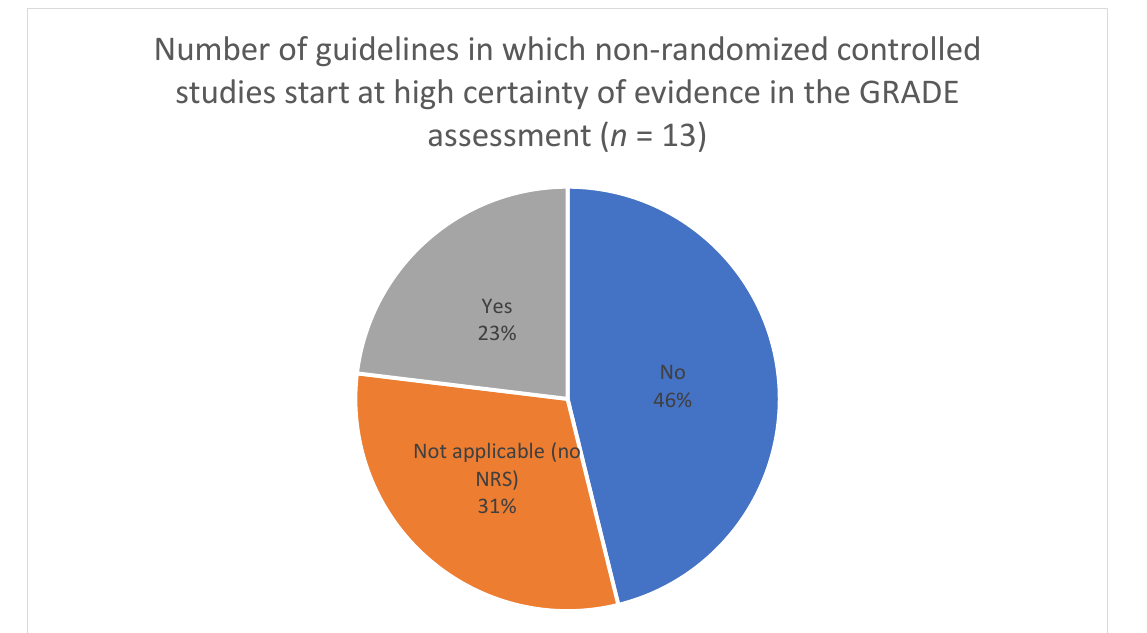
Figure 5. Certainty of evidence assessment for NRS—initial rating at high.